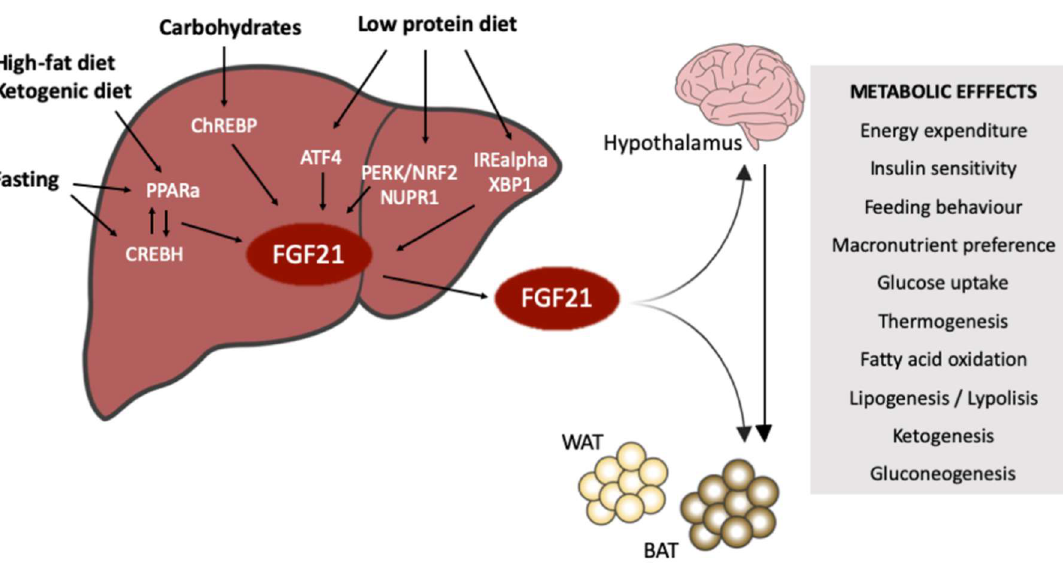
Figure 1. Fibroblast Growth Factor 21 (FGF21) induction by nutritional inputs. Low protein diet, carbohydrates intake, fat consumption, ketogenic diets and fasting are nutritional signals that induce the hepatic expression of FGF21 through different transcription factors. FGF21 as an endocrine factor exerts its metabolic effects mainly in the adipose tissues, directly or indirectly via a liver-hypothalamus axis. The metabolic effects of FGF21 look for restoring metabolic homeostasis by activating different metabolic pathways, but also by changing the macronutrient preferences and the feeding behavior.